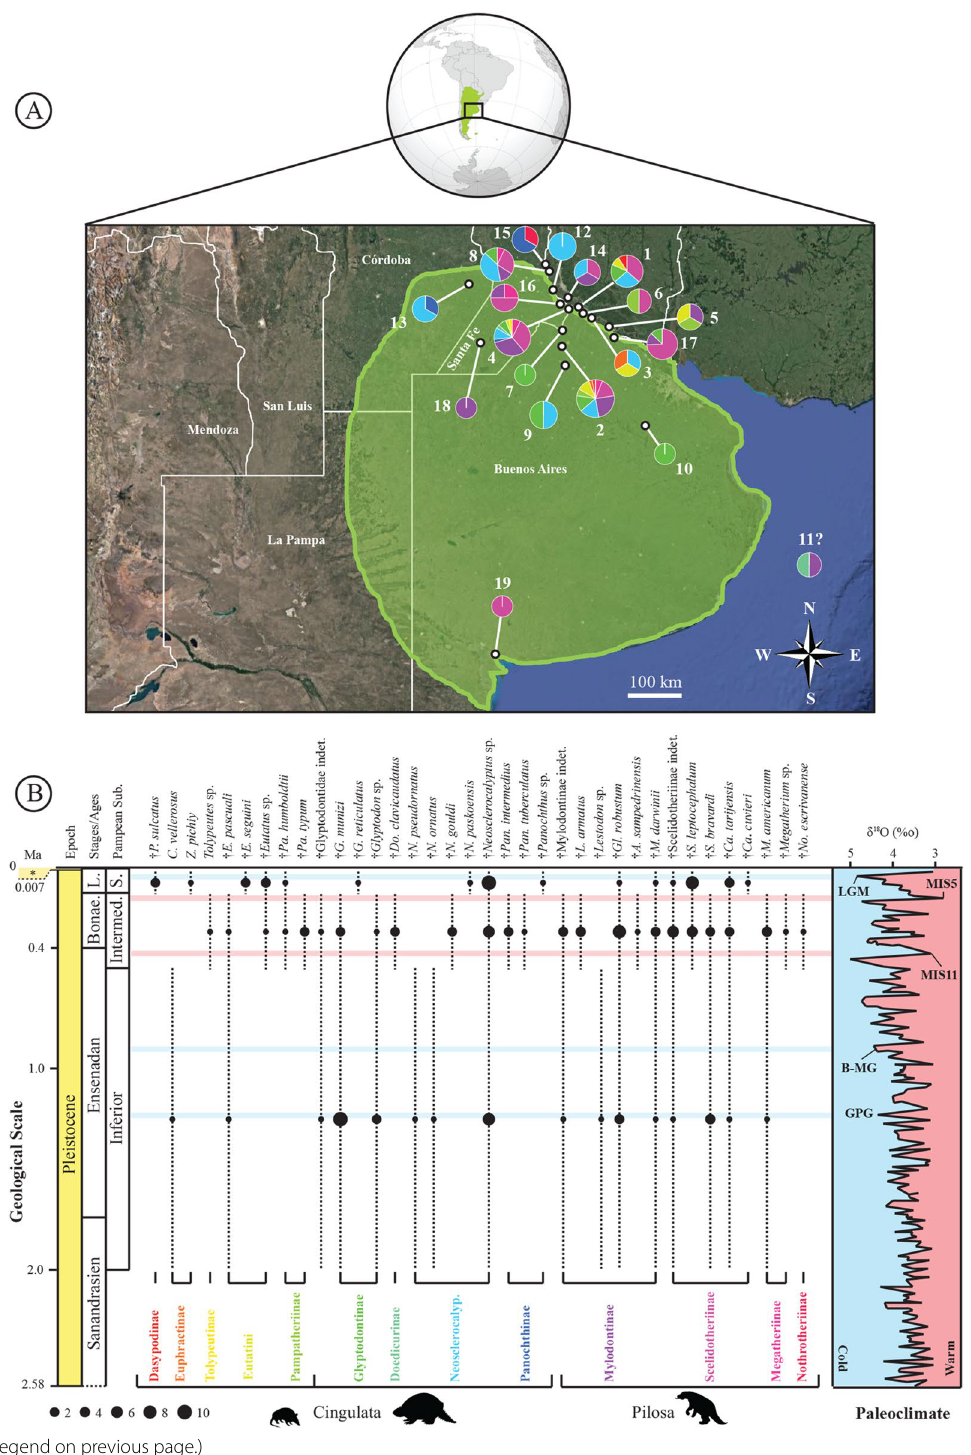
other armadillos. For both clades, the nomenclature used for the rest of the skeleton is specified for each species. No measurements were generated for the present study.